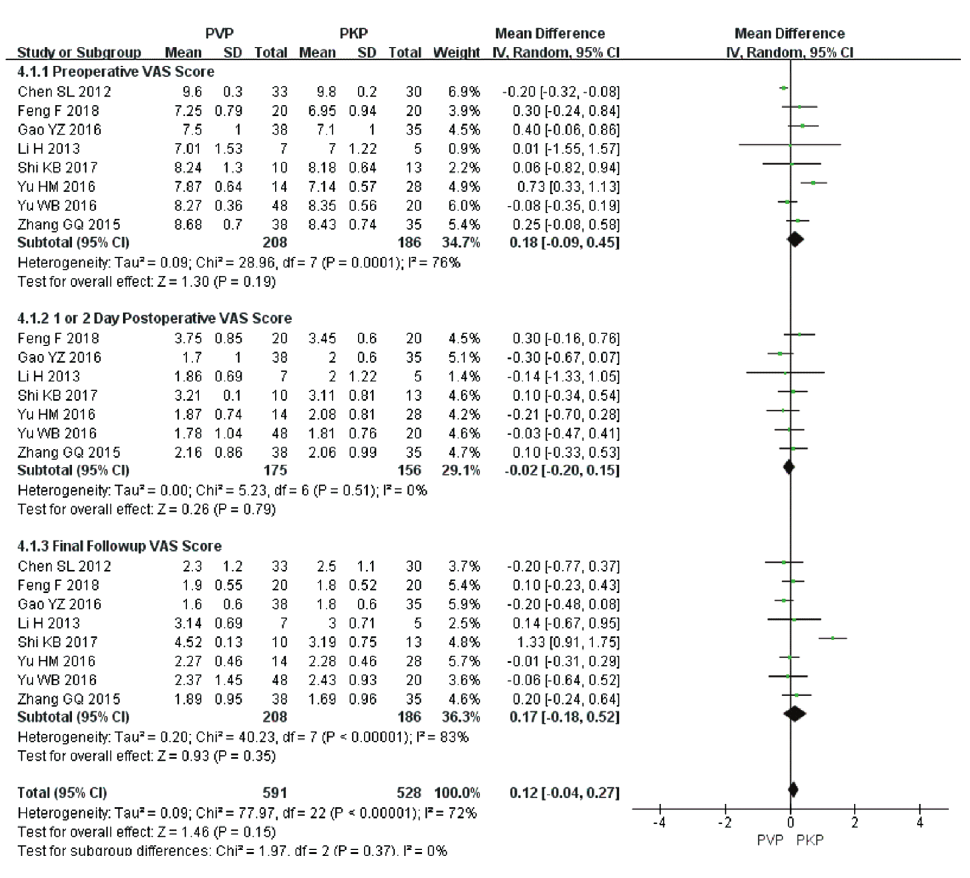
Figure 5. Forest plot to assess VAS score between the two procedures.